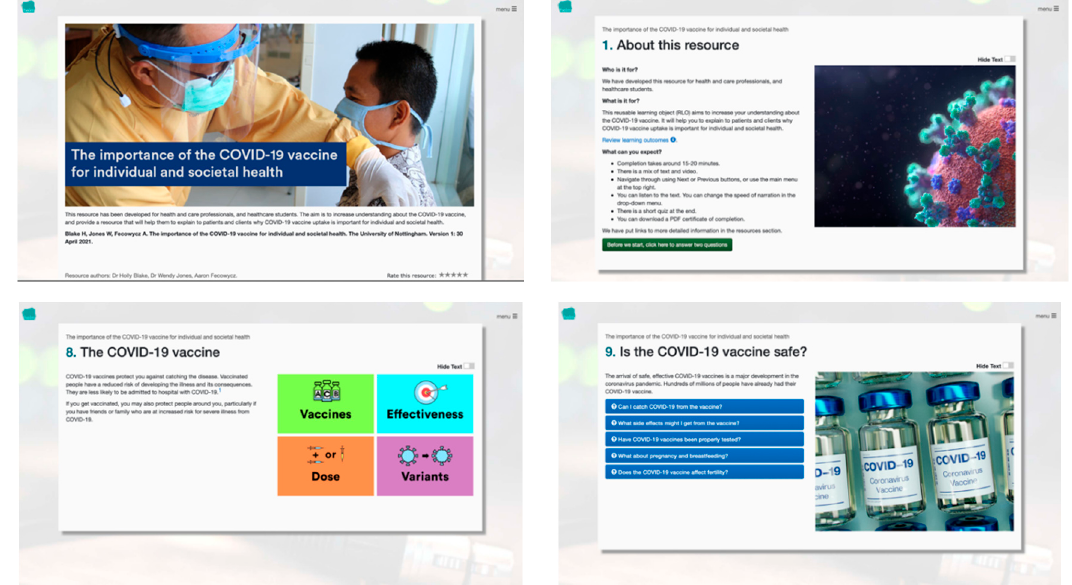
Figure 5. Screen examples from the final developed RLO.